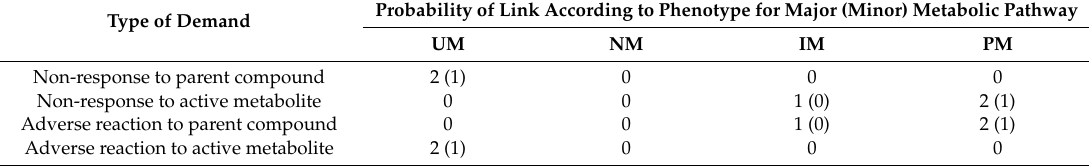
Table A1. Rating scale for the link between the type of demand and predicted phenotype based on diplotype and / or actual